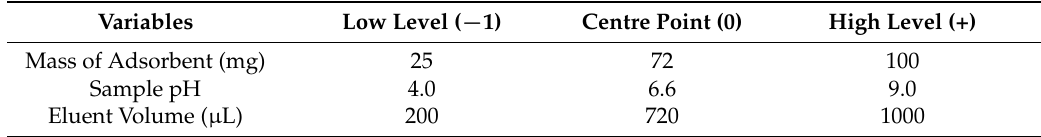
Table 8. Factors and levels of experimental